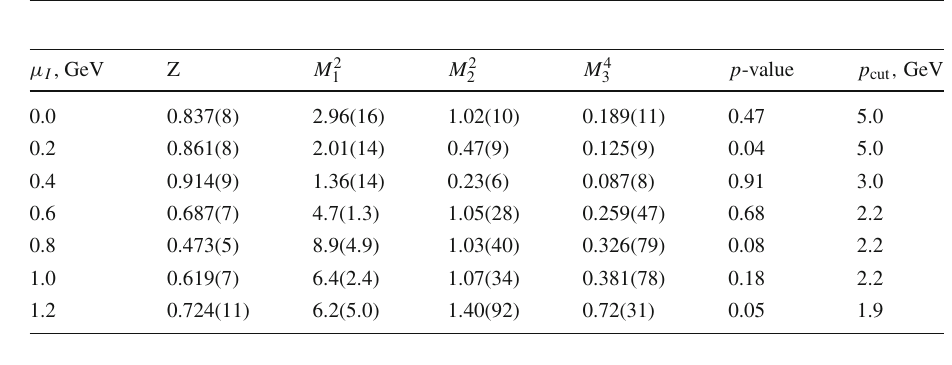
parameters M i , determined by a fit of the formula (23) to D L ( p ) over the range 0 ≤ p < p cut on the cutoff momentum p cut at